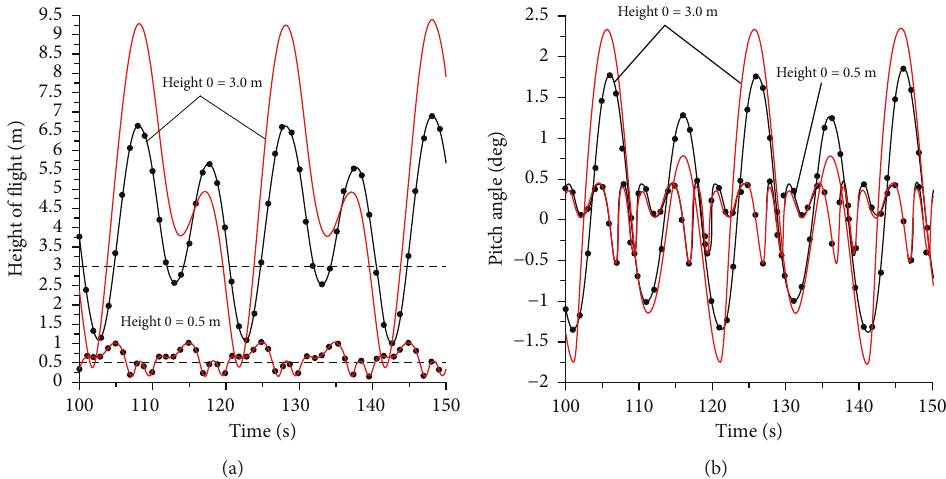
= w sin 2 π t / T , where w = − 2m/s and T = 10s . Black lines x x 0 x 0